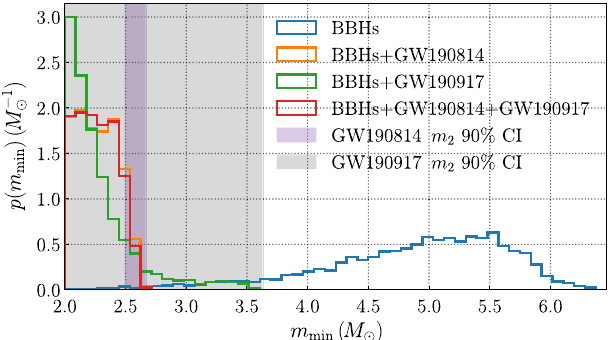
FIG. 14. The posterior distribution on the minimum mass truncation hyperparameter m inferred with the PP model. min The posteriors are shown both including and excluding the two BBH mergers containing low-mass secondaries, GW190814 and 2 M GW190917. The cutoff at m ⊙ corresponds to the lower min ¼ bound of the prior distribution. The inclusion of either of these two events significantly impacts the distribution. The shaded regions indicate the 90% credible interval on the m 2 posterior distribution for the two outlier events GW190814 (purple) and GW190917 (gray).